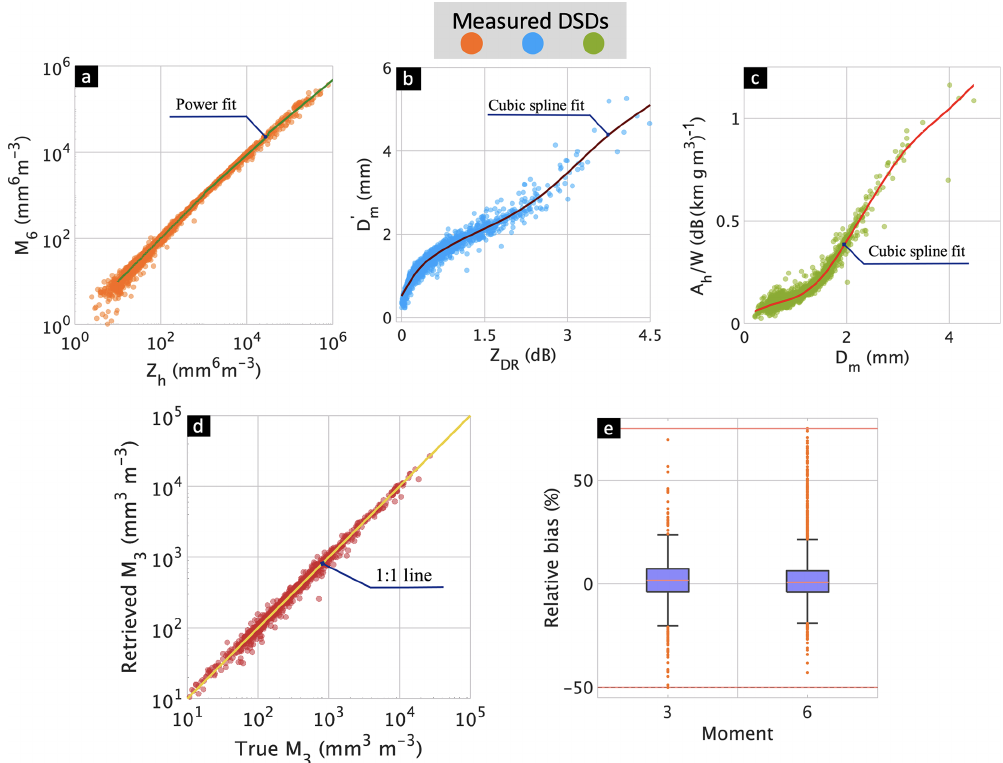
Figure 8. (a) Retrieval of M 6 as a power law of Z h as per Eq. (1); each data point is based on a 3min averaged complete spectrum from either the Greeley, CO, or Huntsville, AL, site. The simulations of X-band Z h , Z DR , and A h are based on assumptions in Sect. 3.3. (b) Retrieval of D (cid:48) m from Z DR along with smoothed cubic spline fit. (c) Same but for retrieval of A h /W from D m , where W is the rain water content. (d) The retrieved M 3 versus “true” M 3 . (e) Box plots of RB for retrieval of M 3 and M 6 (which is a measure of the deviation of the fitted values from the “true” values because of DSD variability). The inter-quartile range is given by the “height” of the dark blue box, while the orange horizontal line inside the blue box is the median. The outliers are shown as orange circles; < 10% are estimated to be outliers. The orange horizontal lines on top and bottom indicate the upper and lower outer fences,